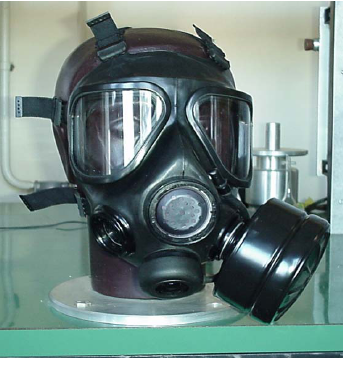
Slika 1 – Funkcionalni model zaštitne maske M3 Pored toga, zaštitna maska pruža zaštitu, uz koriš ć enje odgovaraju- ć ih kombinovanih filtera, od kontaminacije izazvane hemijskim, radioak- tivnim i biološkim agensima u slu č ajevima udesa [4]. U pogledu kompati- bilnosti kod zaštitne maske M3 navedeno je da u zaštitnom položaju ona mora biti kompatibilna sa zaštitnim kombinezonom, zaštitnim ogrta č em, filtriraju ć im zaštitnim odelom i šlemom [4]. Ovaj zahtev, me đ utim, treba proširiti prema svim ostalim sredstvima NVO koji su u nekoj vezi sa zaš- titnom maskom (sl. 2). To zna č i da ona treba da bude kompatibilna sa slede ć im sredstvima NVO: filtriraju ć im zaštitnim odelom, zaštitnim